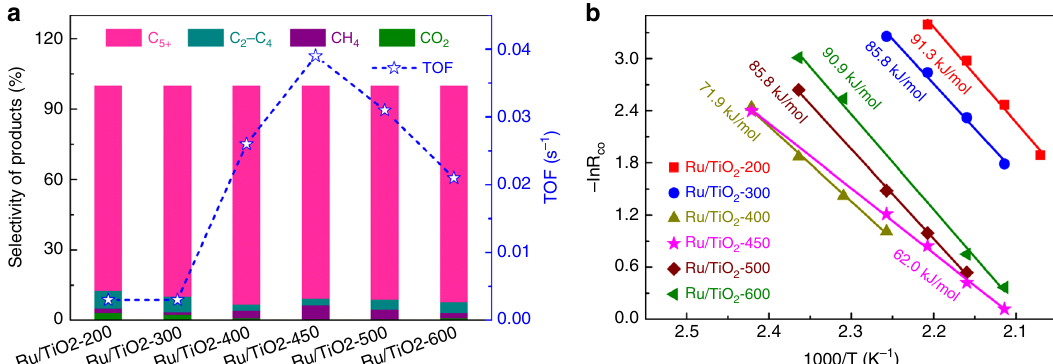
Fig. 3 Catalytic results of the Ru/TiO 2 catalysts for Fischer – Tropsch synthesis. a Catalytic performance of the Ru/TiO 2 catalysts pretreated at different temperatures (Ru/TiO 2 - x samples). Reaction conditions: 2 MPa, 160 °C, space velocity = 1200 – 6000 mL h − 1 g cat − 1 , H 2 /CO/Ar = 64/32/4. b Arrhenius plots for CO hydrogenation over the Ru/TiO 2 - x